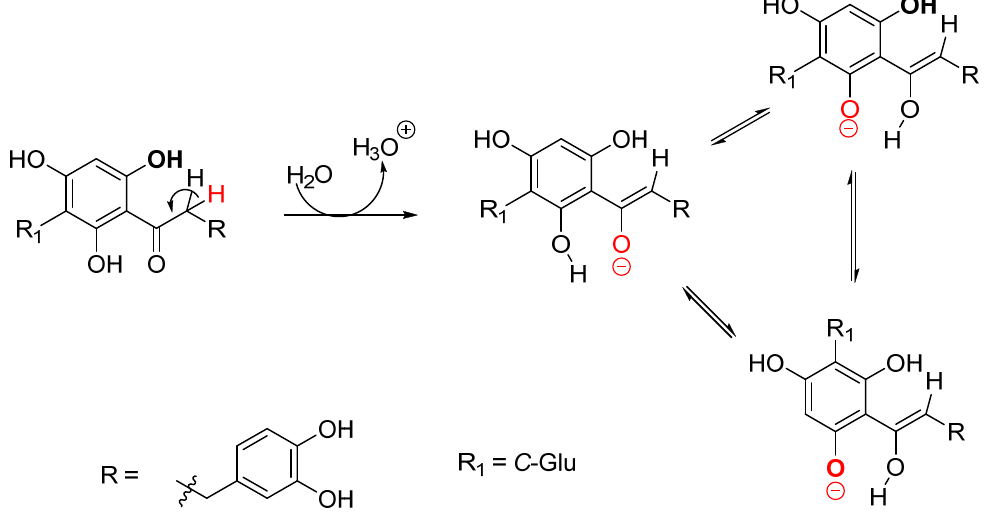
Figure 11. The proposed reduction mechanism of aspalathin . The IR data (Figures 4 and 5) suggest the presence of hydroxyl (3340 cm − 1 ), carbonyls (1710 cm − 1 ), and alcohols (1050 cm − 1 ), which undergoes a slight band shift and intensity.